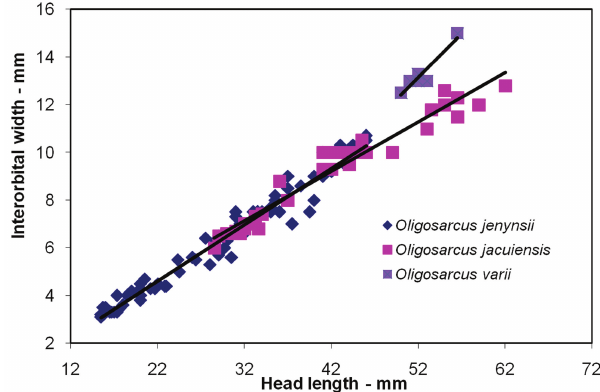
Fig. 3. Least interorbital width as a function of head length for Oligosarcus varii . Oligosarcus jenynsii and O. jacuiensis introduced for comparisons.